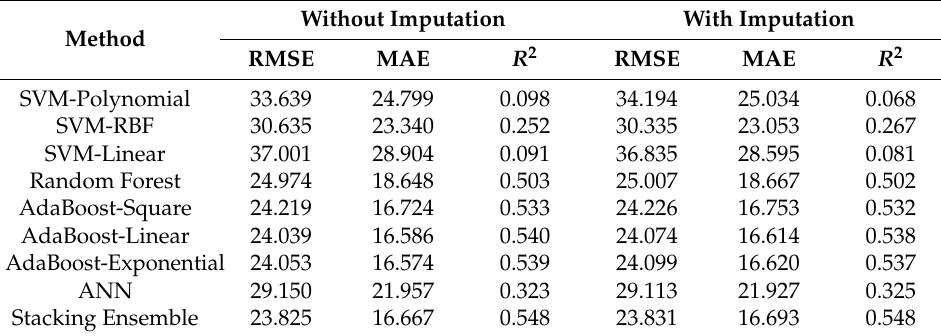
Table 6. Results of ML Algorithms for Zhongli F24-AQI